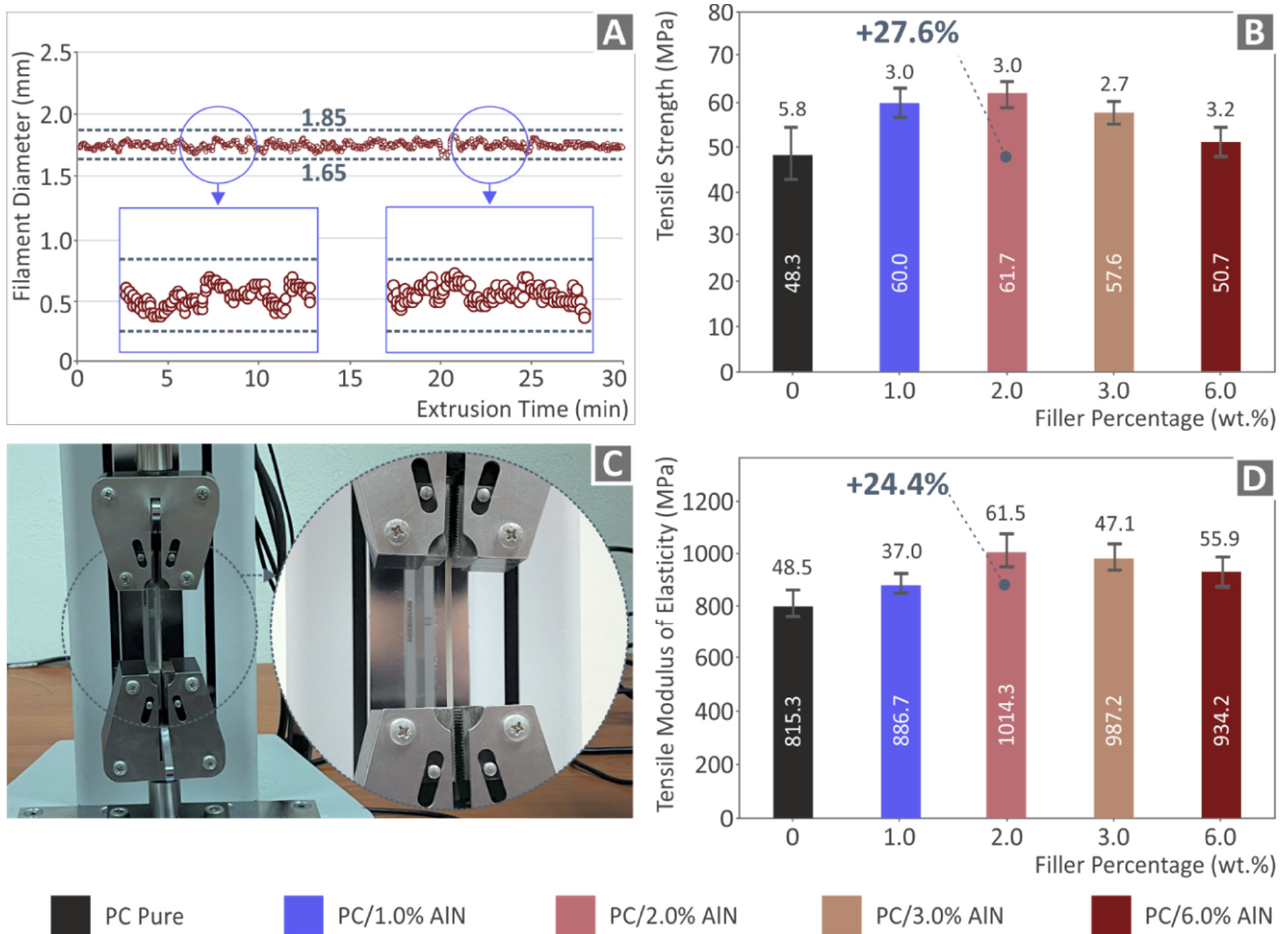
Figure 6. Characterization of all filaments tested: ( A ) real-time filament diameter measurements during the fabrication process, ( B ) tensile strength results (average values and deviation), ( C ) equip- ment for the conduction of tensile tests, and ( D ) tensile modulus of elasticity (average values and deviation) of the five tested filaments.